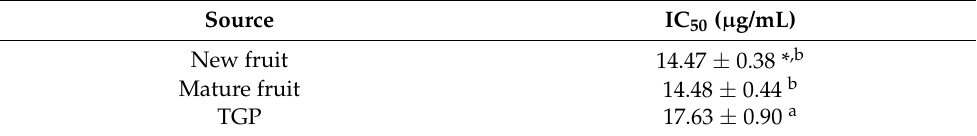
Table 3. IC 50 of TGP and the surface material extract of M. tanarius fruits in scavenging DPPH radicals.